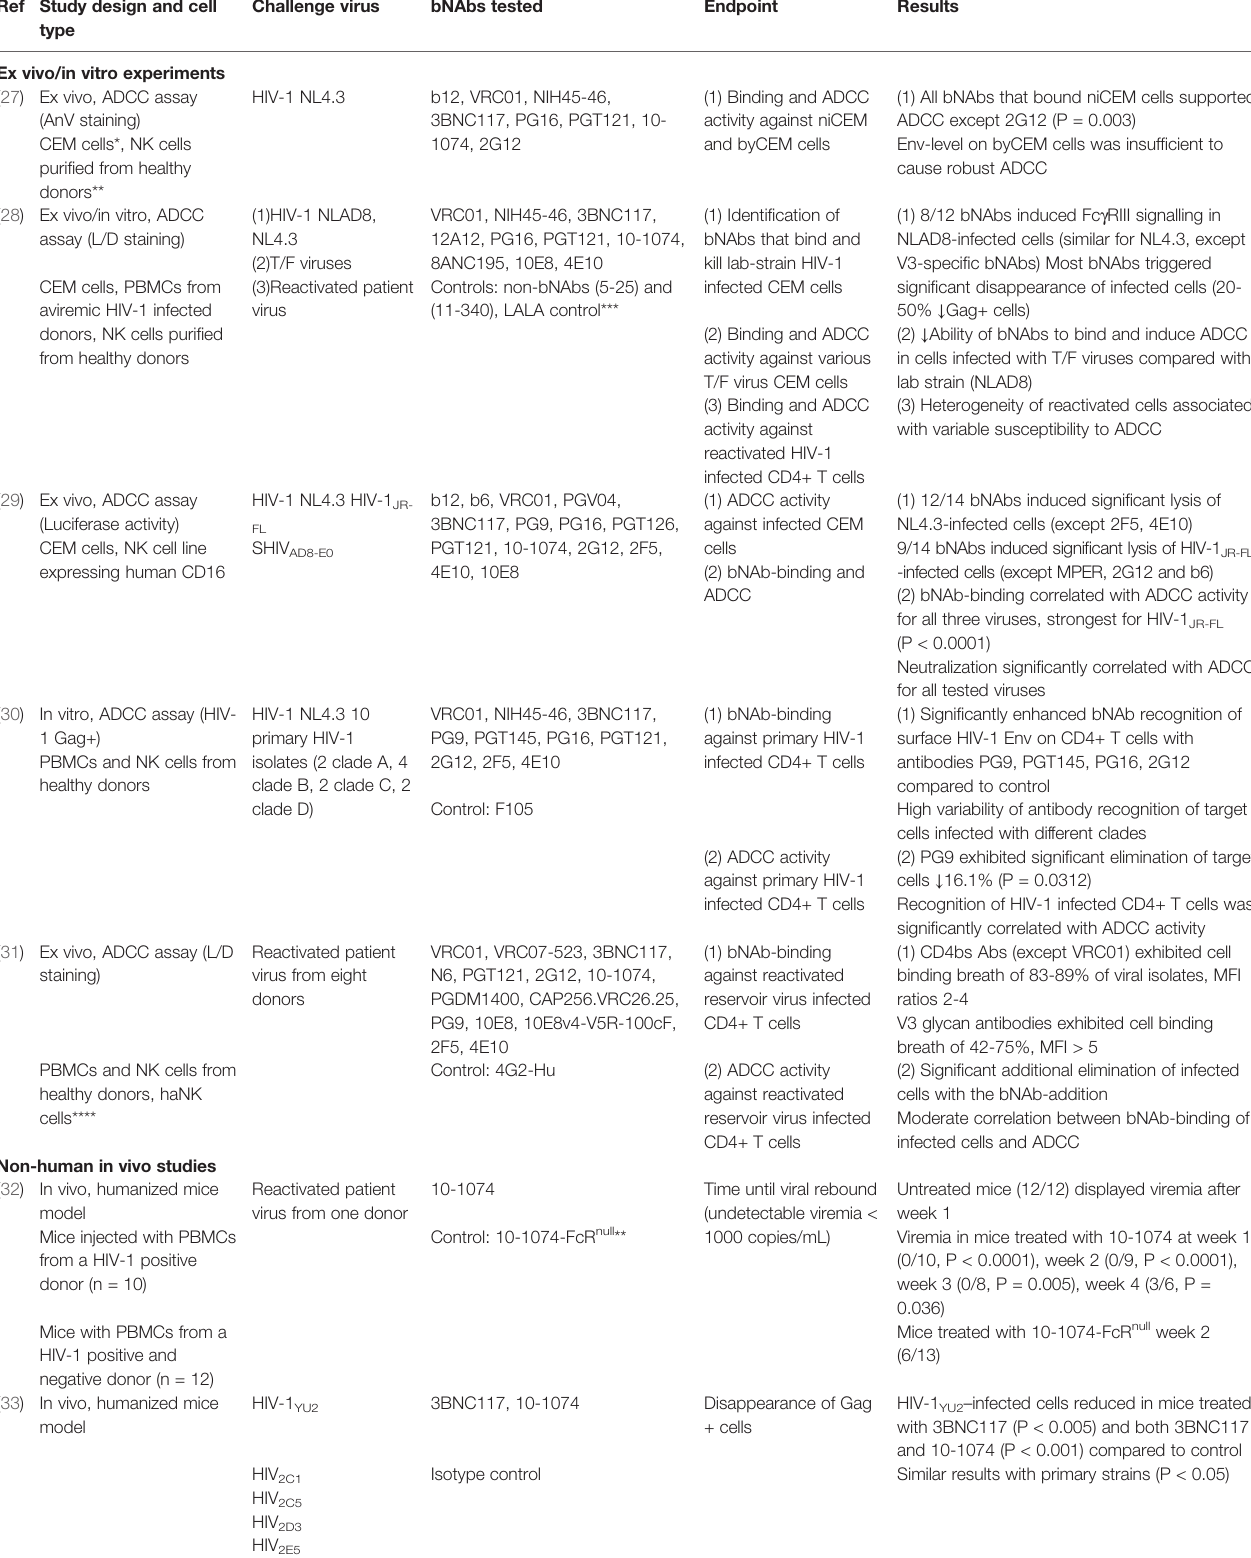
TABLE 2 | Studies investigating ADCC elimination of HIV-1 infected cells by